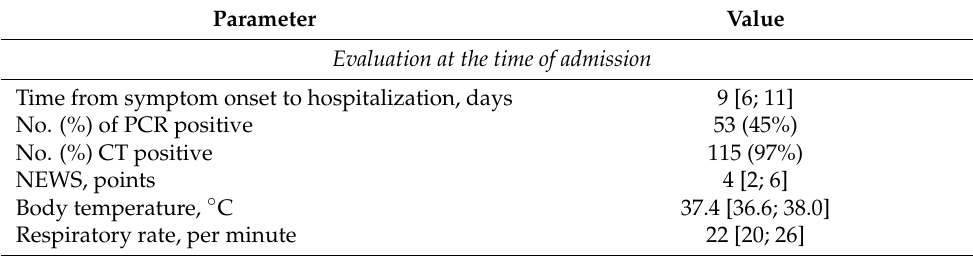
Table 2. The course of the disease in COVID-19